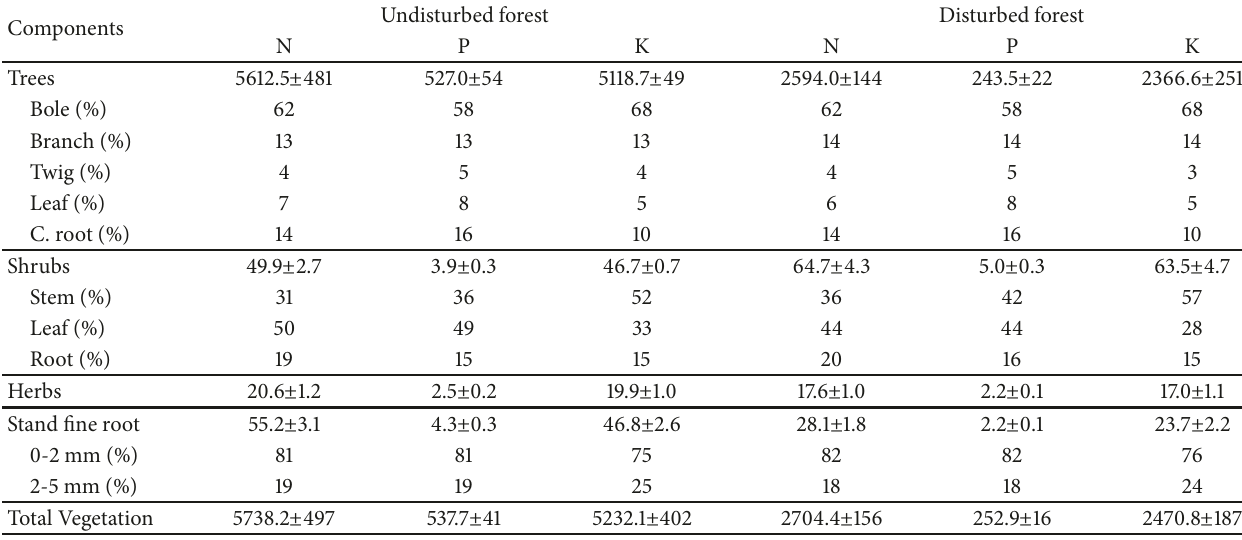
Table 3: Nutrient stocks (kg ha – 1 ) in tree, shrub, herb, and fine root in undisturbed and disturbed forest stands of moist tropical forest of Sunsari district, eastern Nepal (mean ± SE).